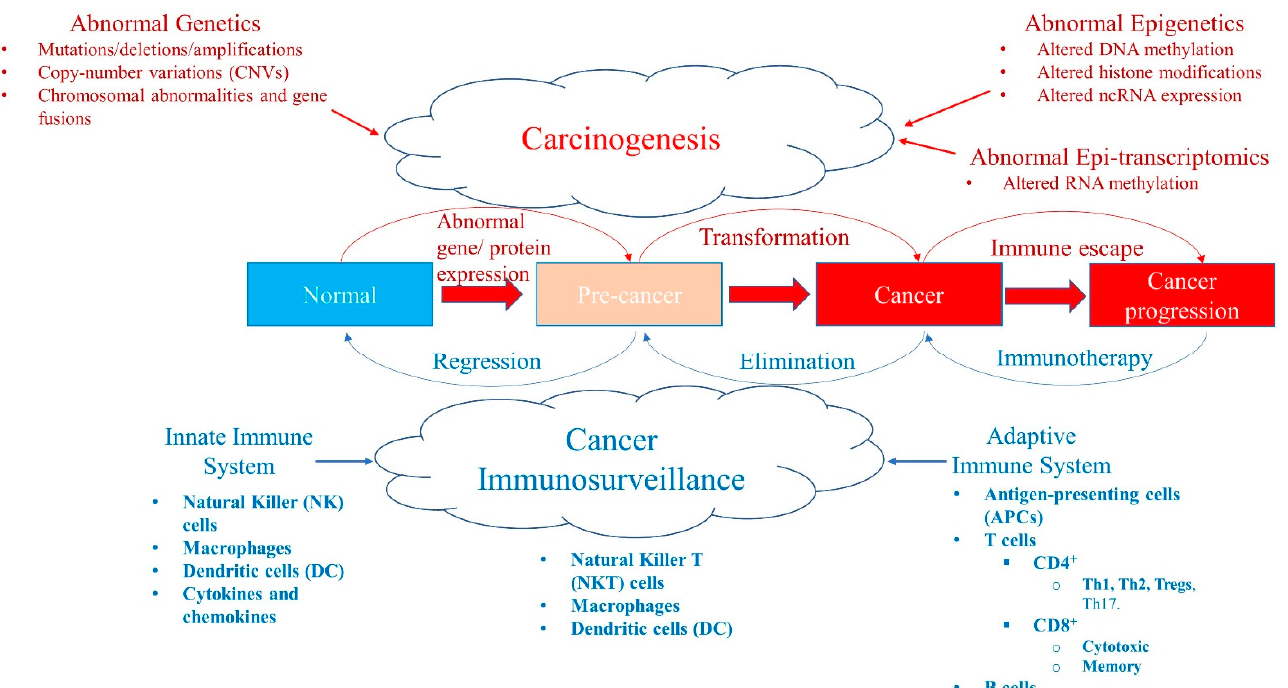
Figure 1. A balance between carcinogenesis and cancer immunosurveillance system. Abnormal genetic modifications such as gene mutations, deletions, amplifications, copy-number variations (CNVs), chromosomal abnormalities, or instability and gene fusions can all result in abnormal expression of genes and proteins leading to transformation of a normal cell into a pre-cancer state and/or cancer stage. Similarly, abnormal epigenetics, such as aberrant DNA methylation patterns, histone modifications, and ncRNA expression (e.g., miRNA) levels, also cause tumorigenesis. Recently, abnormal RNA methylation patterns, such as m 6 A RNA post-transcriptional modifications (epi-transcriptomics), have been shown to result in the initiation and progression of cancer. Although these abnormalities in malignancy promote tumorigenesis, the cancer immunosurveillance system acts as a tumor suppressor working against the formation of pre-malignant and cancer cells. The cancer immunosurveillance system comprises the innate and adaptive immune systems that have various components that help to regress or eliminate tumor cells. However, some immune cells can be pro-tumor, which paradoxically help tumor progression in the tumor microenvironment. Cancer can evolve and escape the immune system by developing immunosuppressive escape mechanisms (such as high expression of PD-L1) that allow it to progress. This state can be reversed with immunotherapy, such as immune checkpoint inhibitors (ICPi).